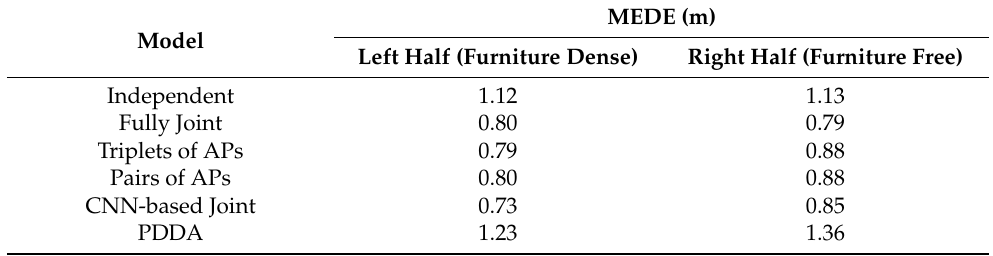
Table 3. Comparison of each model’s MEDE on the left and right halves of the high furniture room. MEDE (m) Model Left Half (Furniture Dense) Right Half (Furniture Free) Independent 1.12 1.13 Fully